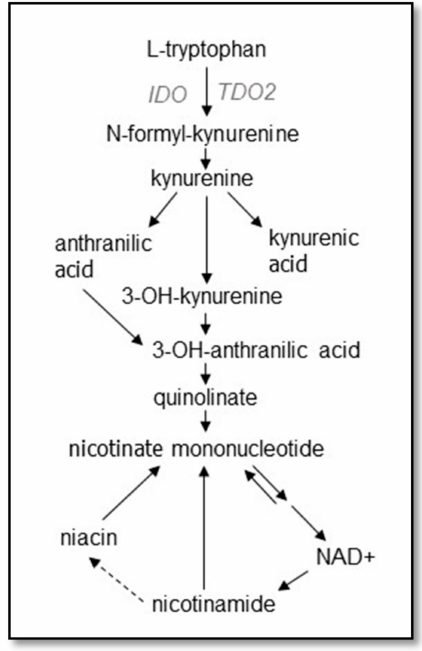
Figure 5. Primary components of the kynurenine pathway, from the substrate tryptophan to the end product, NAD+. The dashed line indicates the reaction is carried out by bacterial enzymes in the human